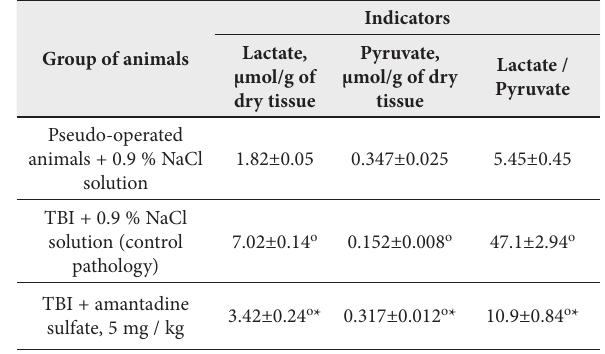
Effect of 8-day infusion course of amantadine sulfate on the content of glucose metabolites in the brain of rats